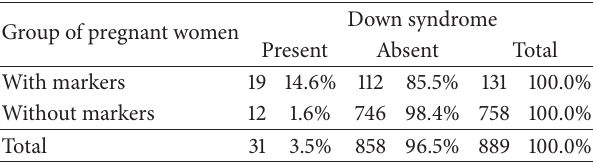
Table 1: Description of the cases of Down syndrome according to the groups with and without ultrasound markers ( 𝑃 < 0.001